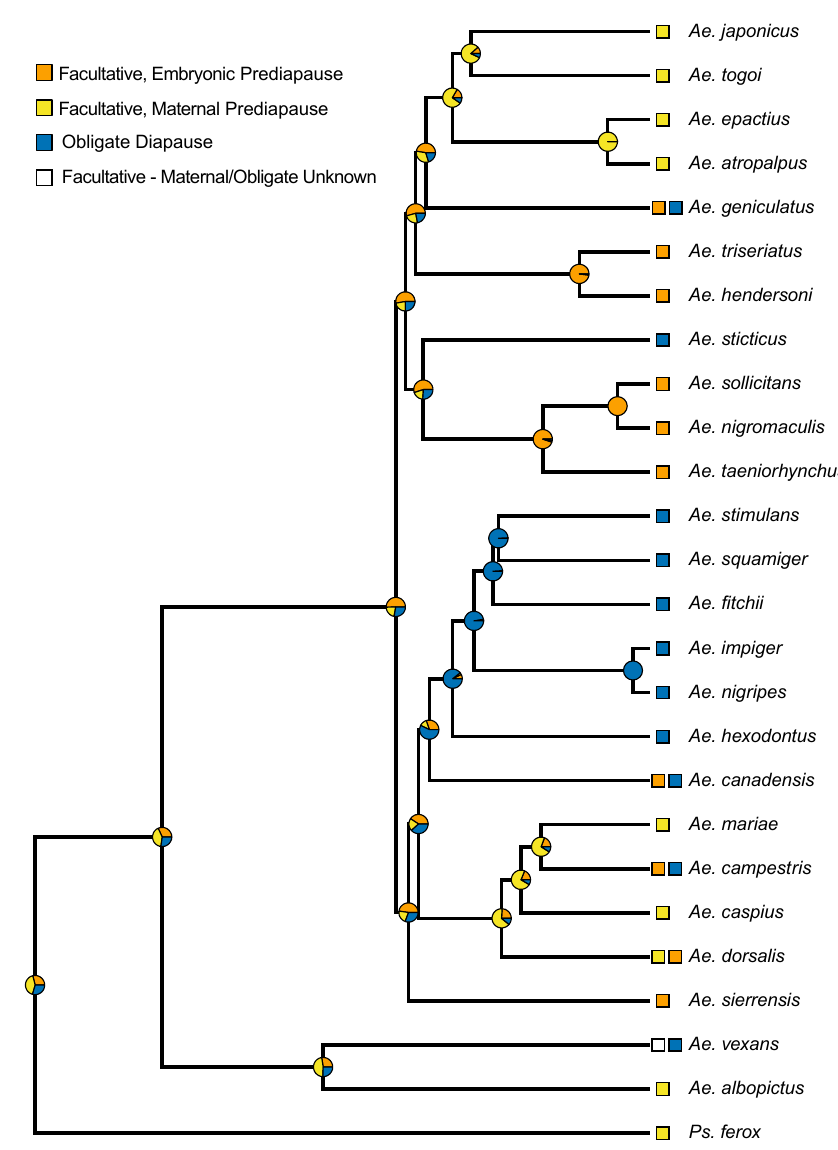
Figure 3. Phylogeny of known prediapause stages in Aedes that undergo embryonic diapause. Species with two prediapause stages have obligate univoltine and facultative multivoltine individuals. Some species utilize multiple life-cycle diapause stages and represented here is the prediapause stage solely to induce embryonic diapause. Phylogeny from Soghigian et al. [11], with posterior probabilities from an ancestral state reconstruction shown on nodes.